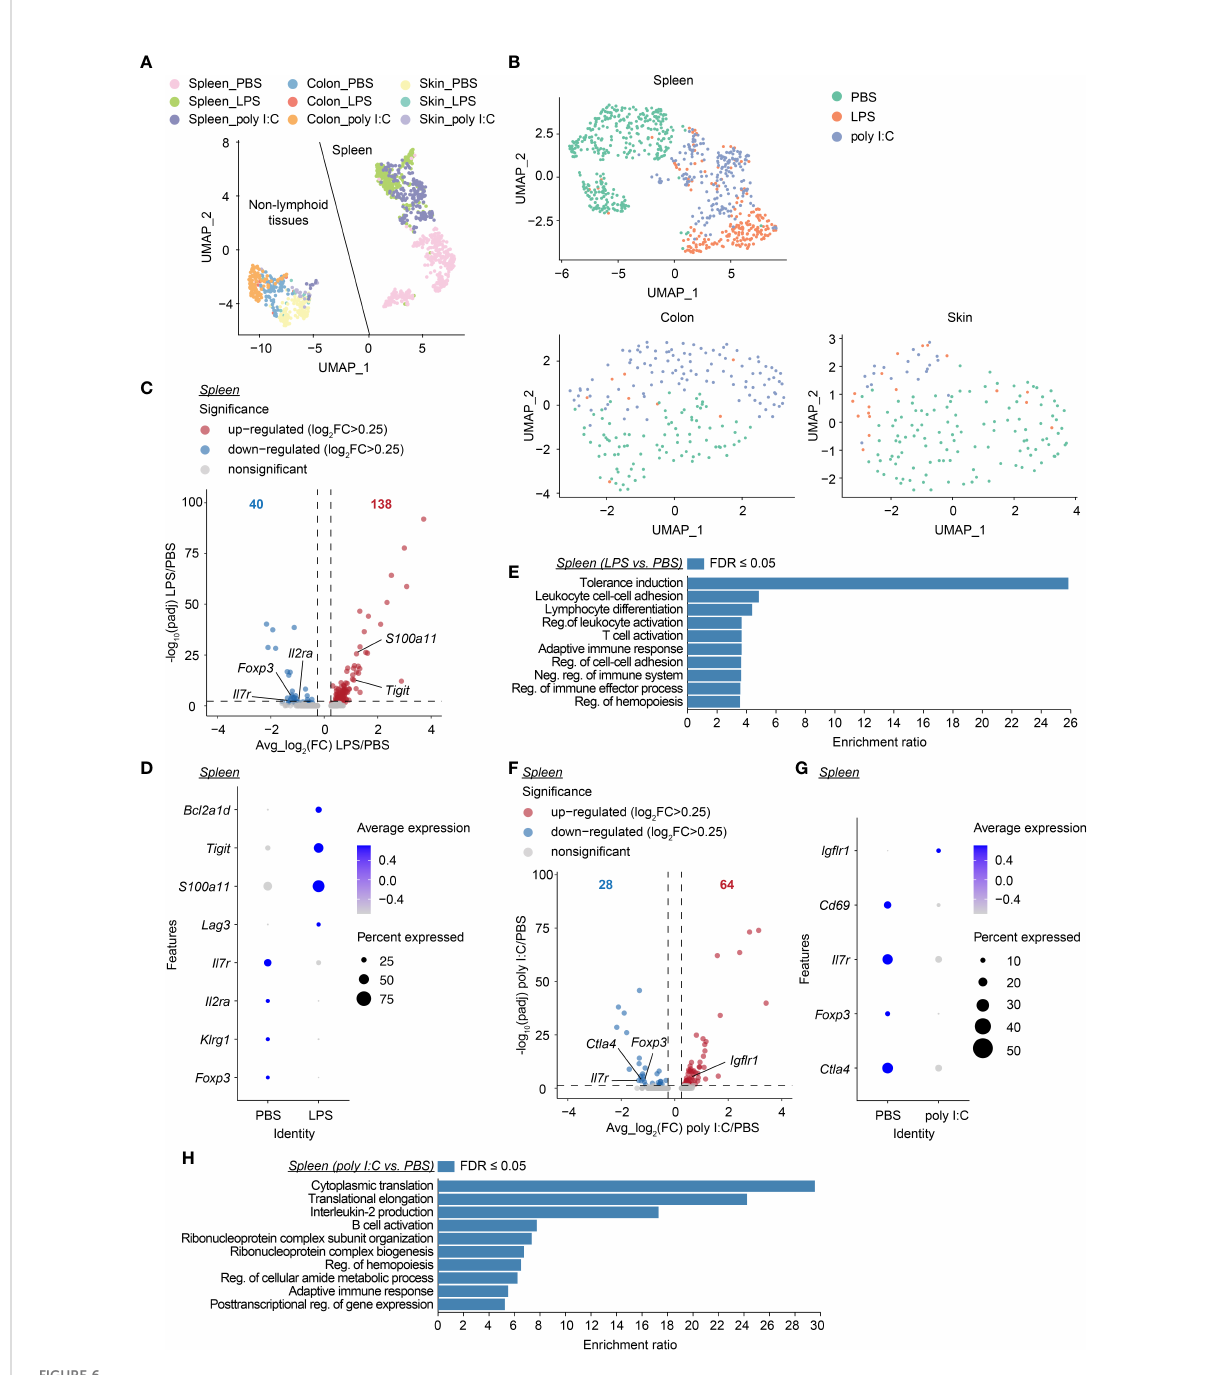
FIGURE 6 Long-lastingly altered transcriptomic pro fi les of neonatally-tagged Tregs upon neonatal challenge. Newborn Foxp3 eGFPCreERT2 xROSA26 STOP-eYFP mice were intraperitoneally injected with LPS, poly I:C or PBS as control, followed by repetitive intragastric injections of tamoxifen at days 2, 5 and 8 after birth. Twelve weeks later, YFP + cells were FACS-sorted and subjected to combined scRNA/TCR-seq. (A) UMAP plot of merged YFP + cells from spleen, colon, and skin of the fi rst batch of PBS-, LPS- and poly I:C-treated mice. (B) UMAP plots of merged YFP + cells across organs of PBS-, LPS- and poly I:C-treated mice. (C) Volcano plot depicts avg_log 2 (FC) vs . -log 10 (padj) of identi fi ed DEGs between LPS and PBS conditions in the spleen. (D) Dot plot shows the expression of selected genes in splenic YFP + cells of PBS- and LPS-treated groups. (E) GO analysis of all DEGs identi fi ed in (C) (F) Volcano plot depicts avg_log 2 (FC) vs . -log 10 (padj) of identi fi ed DEGs between poly I:C and PBS conditions in the spleen. (G) Dot plot shows the expression of selected genes in splenic YFP + cells of PBS- and poly I:C-treated groups. (H) GO analysis of all DEGs identi fi ed in (F) UMAP, uniform manifold approximation, and projection; FC, fold change; DEG, differentially expressed gene; GO, gene ontology; Reg., regulation; Neg.,